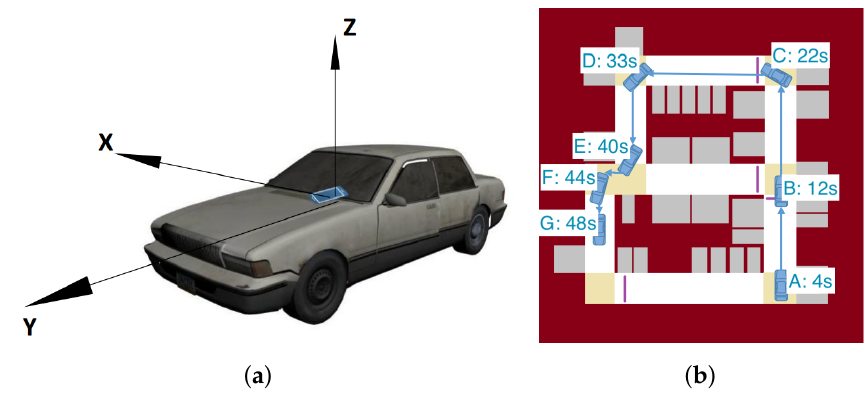
Figure 2. The vehicle coordinate system and the map of an example vehicle route. Seven key points are demonstrated with time stamps. The vehicle starts at A and stops at G. The timer starts before the vehicle starts and its time is recorded at every key point. ( a ) Vehicle coordinate system; ( b ) Map of the example scenario shown with the